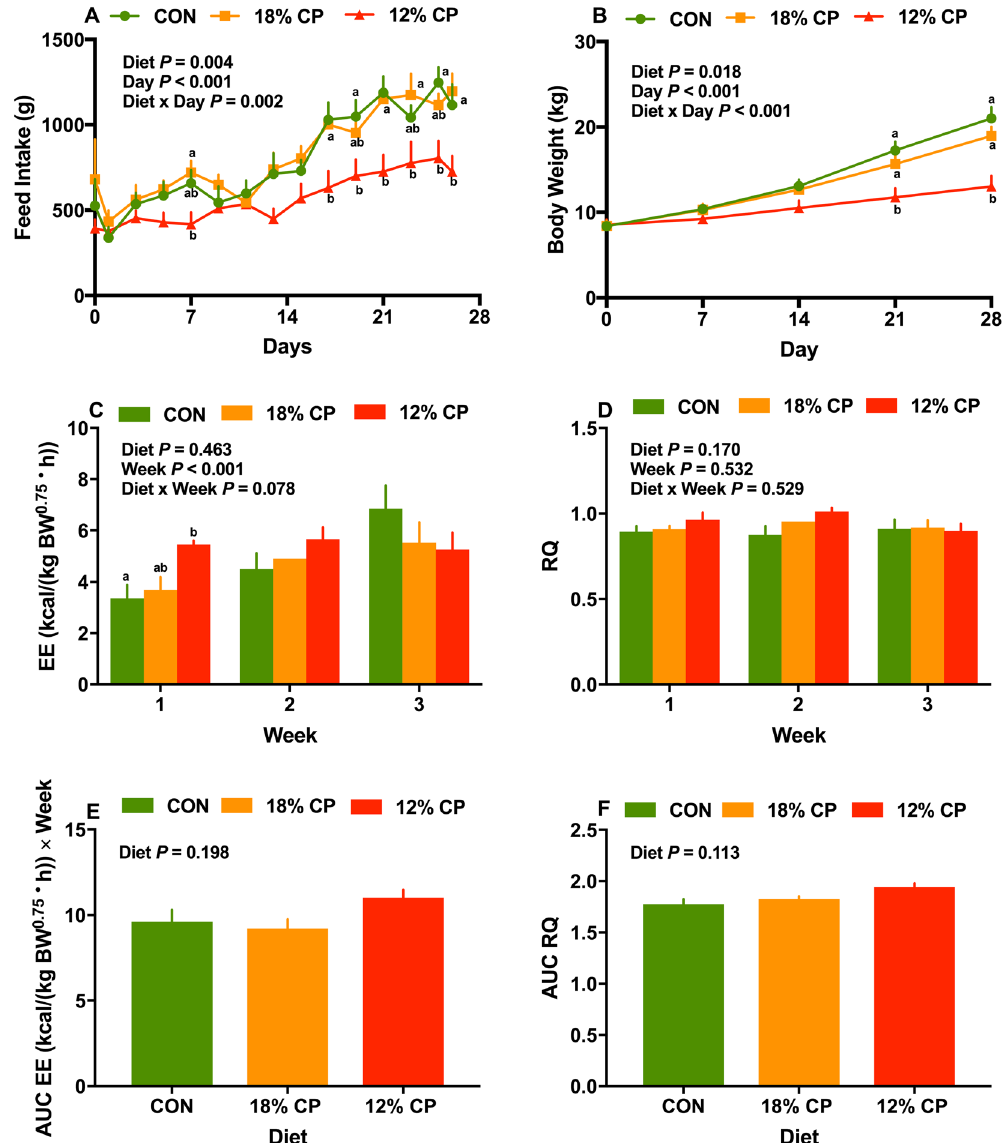
Figure 1. The effect of low protein diets on energy balance. ( A ) feed intake, ( B ) body weight, ( C ) mean energy expenditure (EE), ( D ) mean respiratory quotient (RQ), ( E ) area under curve (AUC) for EE, ( F ) AUC for RQ. CON, control diet with 24% crude protein (CP); 18% CP, low protein diet with 18% CP; 12% CP, low protein diet with 12% CP. Among groups, values with different superscripts are significantly different (P < 0.05). The values are means ± standard errors of means. n = 12, n = 12, n = 13 for CON, 18% CP and 12% CP groups, respectively for feed intake and body weight data; n = 7, n = 7, n = 8 for CON, 18% CP and 12% CP groups, respectively for EE and RQ